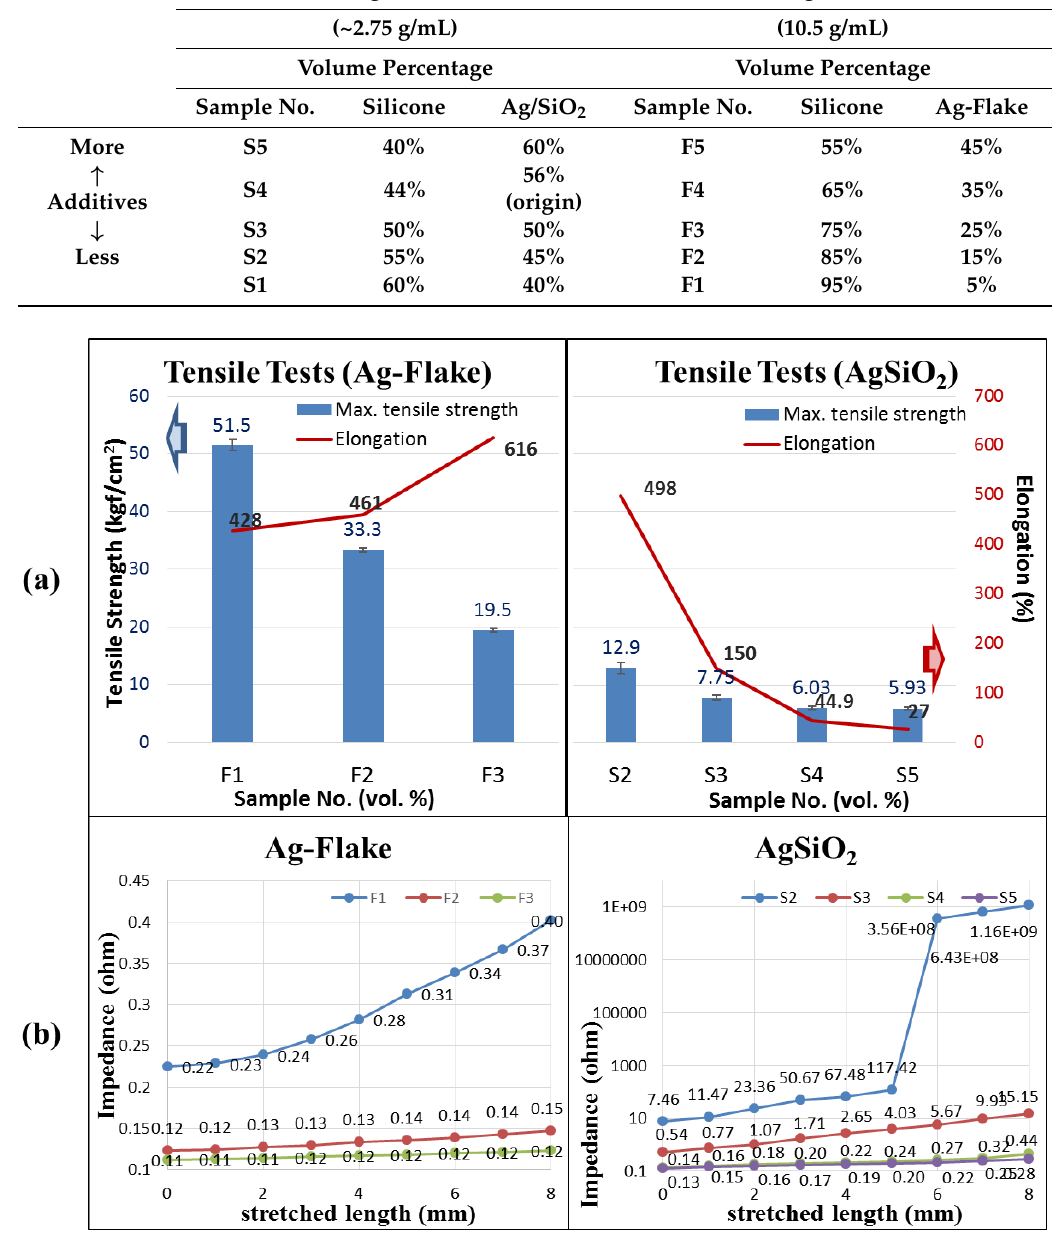
Figure 3. ( a ) Mechanical properties as a function of composition for both Ag-flake and Ag/SiO 2 . ( b ) Strain-dependent impedance measurements obtained from compositions containing Ag-flake and Ag/SiO 2 .